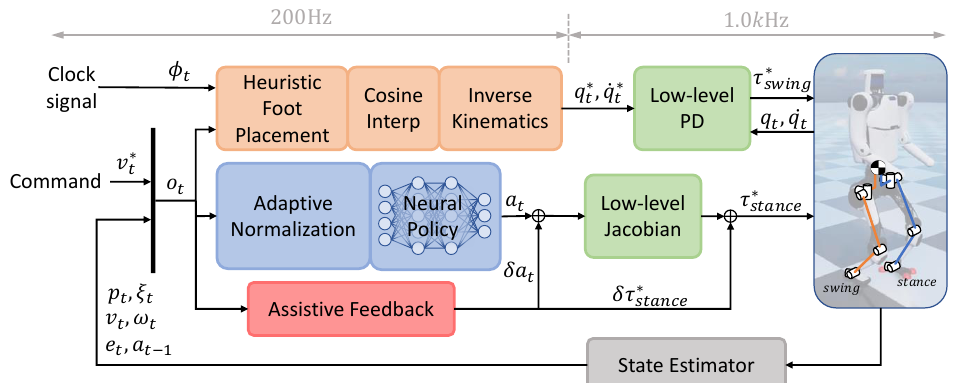
Figure 2. Control framework of hybrid walker. Locomotion task is divided into two different phases and managed by two separate branches. Heuristics swing controller (orange blocks) controls swing leg with a low-cost position-based approach. Learning-based stance controller (blue blocks) adopts NN policy for controlling. Assistive branch (red block) is active only on the real robot for compensating reality gap. Clock signal φ is a periodic ramp signal that increases from 0.0 to 1.0 throughout a gait